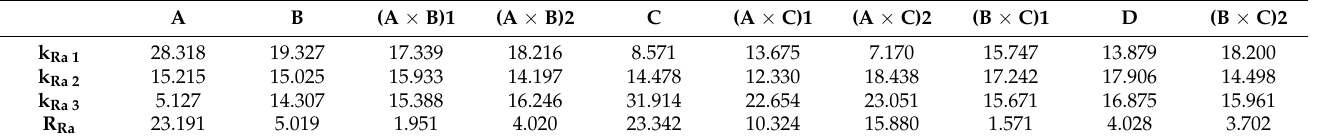
Table 6. Range analysis for Ra.